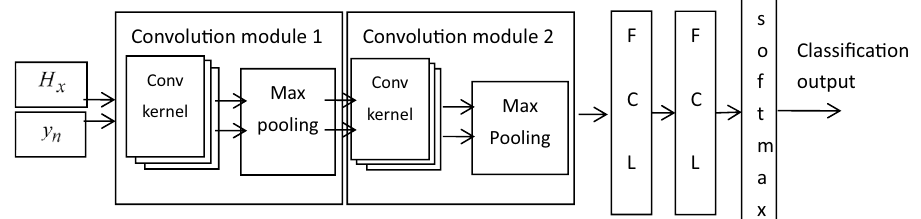
Figure 2. The overall structure diagram of pulse signal classification (Fully connected layer-FCL).